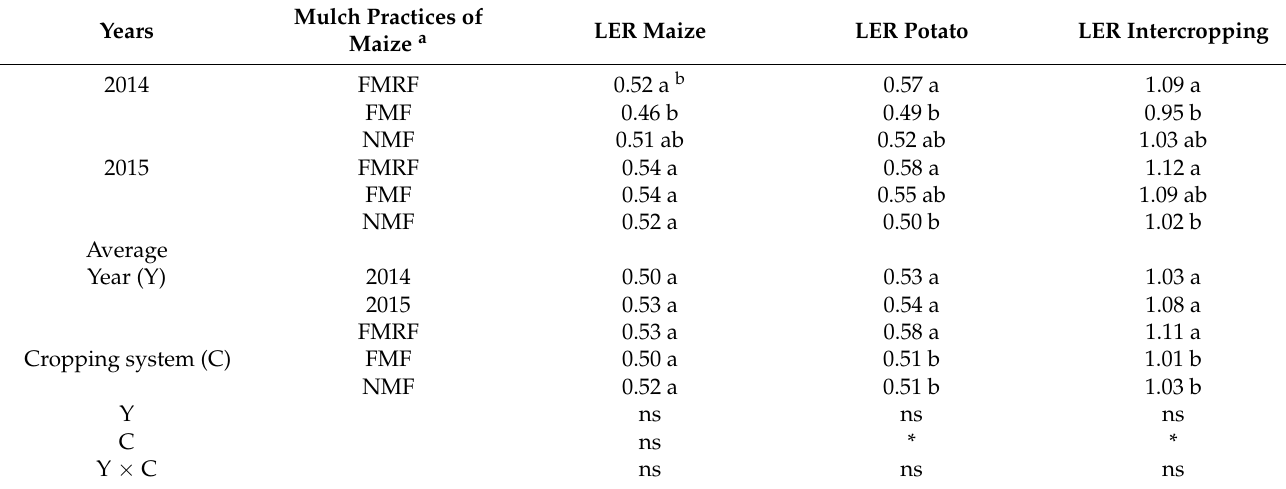
Table 3. Land equivalent ratio in the maize/potato intercropping system in 2014–2015.